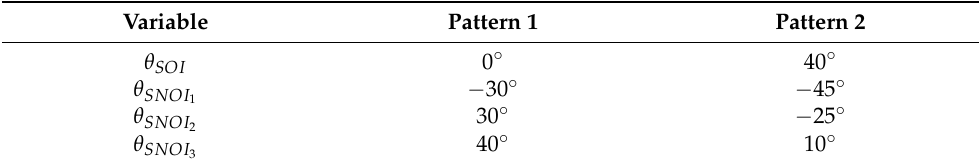
Table 1. Specifications of the beamforming patterns.